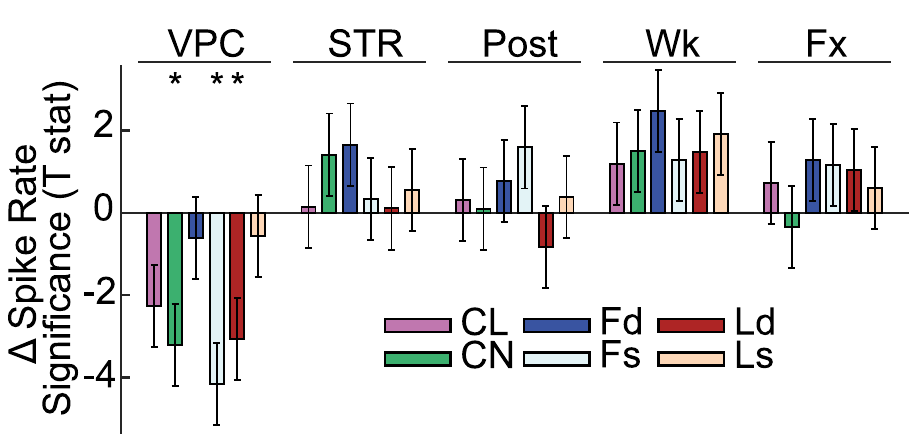
Fig 8. Neural firing rates decrease during VPC relative to control conditions. Spike rate differences normalized to the pre-condition ( ± SE of the point estimate) for different brain areas under VPC, control stare (STR), post, resting wake (RW), and fixation (FX) conditions. Neurons were analyzed in resting wake, fixation, and pre/post-event epochs only for neurons recorded during VPC or STR events (N CL = 60, N CN = 19, N Fd = 15, N Fs = 38, N Ld = 46, N Ls = 21). (t(25) = -2.26, n = 26, p = .033, p = .098). These results could reflect changes in neural gain/ c excitability, or reduced drive along specific input pathways.